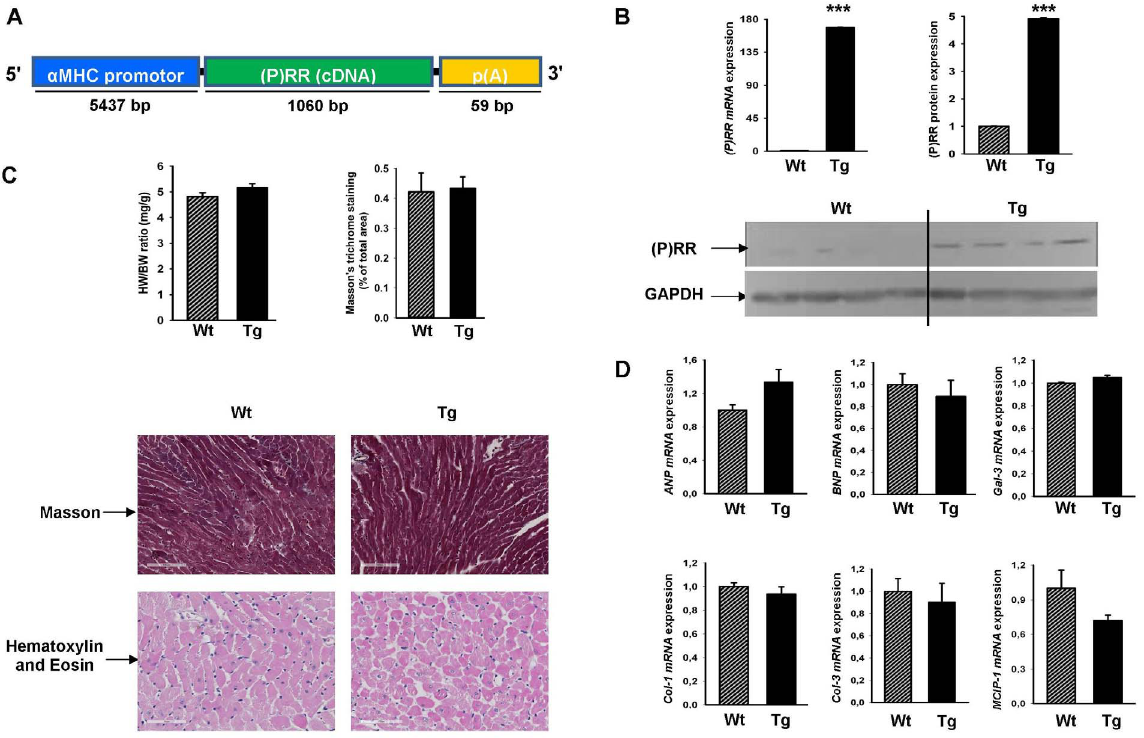
Figure 1. Generation of (P)RR transgenic mice and baseline characteristics. A) Schematic depiction of the generation of Tg mice with cardiomyocyte-restricted (P)RR overexpression. We cloned the 1060 bp murine (P)RR cDNA in front of the a 5.5-kb a -MHC promoter. B) (P)RR mRNA expression normalized to 36B4 by RT-PCR of Tg mice and their Wt littermates (left upper panel); western blot for (P)RR and GAPDH protein from hearts of Tg and Wt mice (bottom panel) and quantification of the western blot (right upper panel). C) Heart-weight (HW) normalized to body weight (BW) in adult Wt and Tg mice (left upper panel); images for Masson staining for quantification of fibrosis (bar size 100 m m) and haematoxylin and Eosin staining (bar size 70 m m) for assessment of cardiac morphology (bottom pannels) and quantification of Masson staining (right upper panel). D) mRNA expression of ANP , BNP , Gal-3 , Col-1 , Col-3, and MCIP1 (normalized to 36B4 ) of the Wt and Tg mice. Fold changes are shown. *** P , 0.001 , Wt vs. Tg.